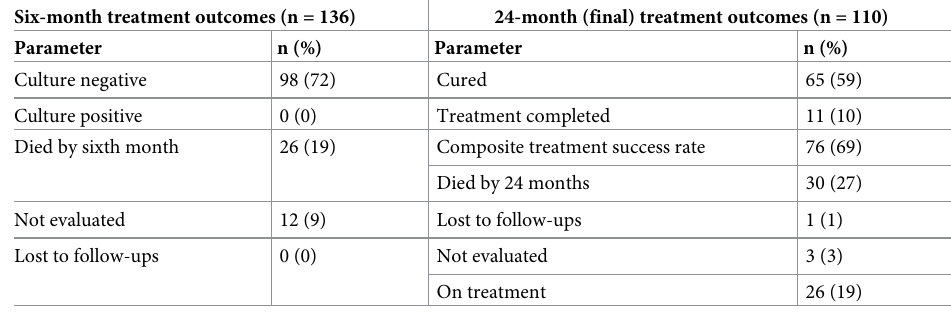
Table 2. The treatment outcomes of patients with MDR-TB at six and 24 months after commencing treatment. Six-month treatment outcomes (n =